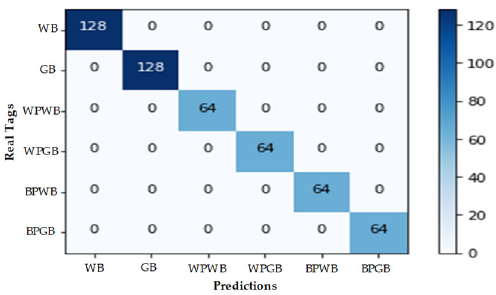
Figure 18. Confusion matrix. Tags: white background (WB), green background (GB), white piece on white background (WPWB), white piece on green background (WPGB), black piece on white background (BPWB), and black piece on green background (BPGB).